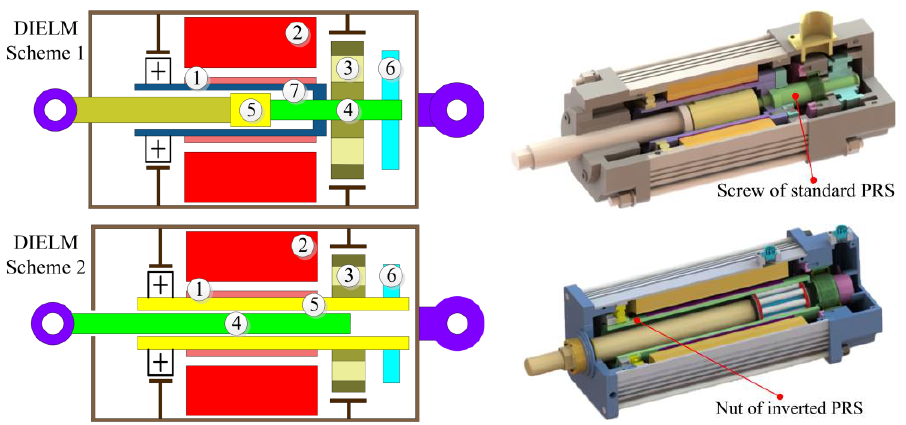
Figure 2. Structural representation and three-dimensional diagram of two DIELM schemes.